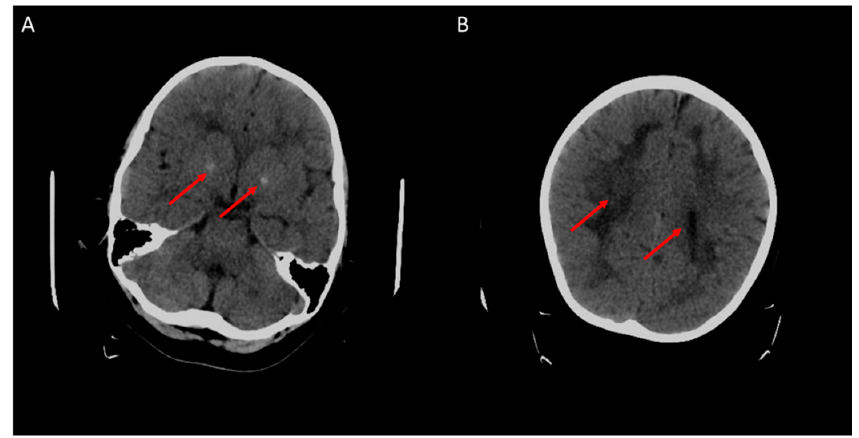
Figure 3. Cerebral CT ‐ scan at 4 years old. Red arrows show brain calcifications ( A ) and diffuse white matter abnormalities ( B ).